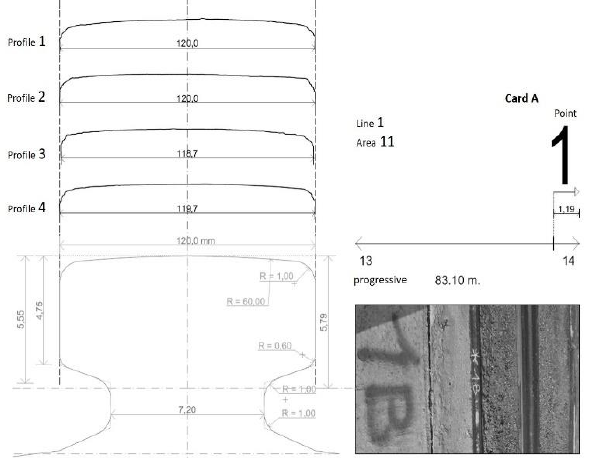
Figure 10. Evaluation of wear through a comparison of profiles